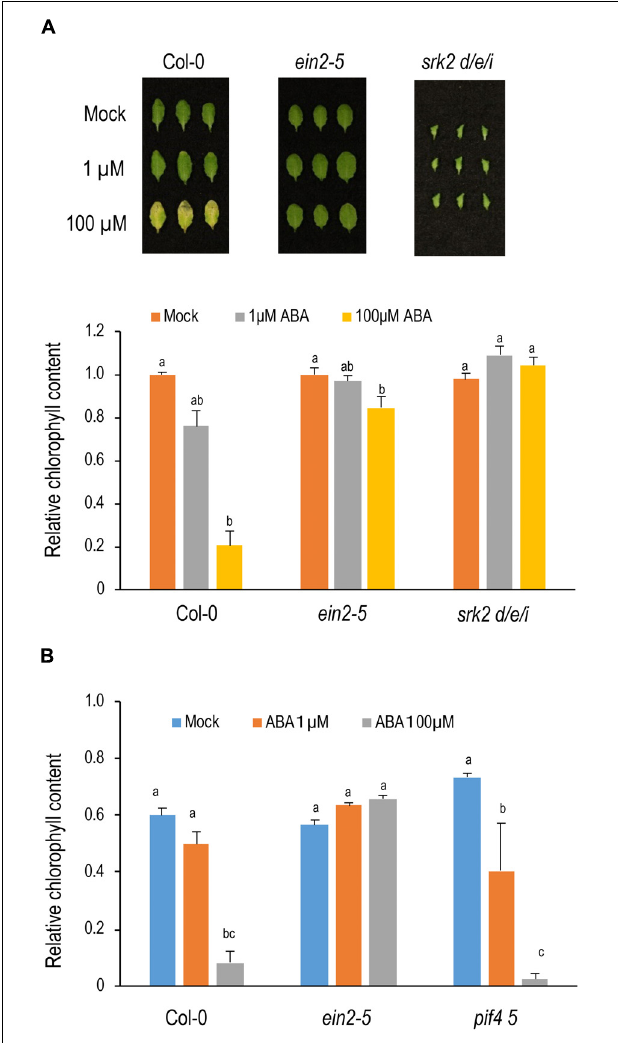
FIGURE 3 | Sensitivity of ein2 and pif4 pif5 to ABA in leaf senescence. (A) Sensitivity of ein2-5 and srk2d/e/i to ABA in leaf senescence under light conditions. Leaves positioned 8th from the top of 4-week-old plants were incubated on the medium containing 1 or 100 µ M ABA for 3 days under light conditions. Lower panel shows chlorophyll content (SPAD value) relative to those of mock condition in each genotype. (B) Sensitivity of ein2-5 and pif4 pif5 to ABA in leaf senescence under dark conditions. The 8th leaves were incubated on the medium containing 1 or 100 µ M ABA for 3 days under dark conditions. Chlorophyll content (SPAD value) were relative to those before ABA treatment in each genotype. Data were statistically compared using Tukey’s multiple comparison method in each genotype in A and in all genotypes in B ( p < 0.05). Bars indicate standard errors ( n = 8 in A , and n = 4 in B ).